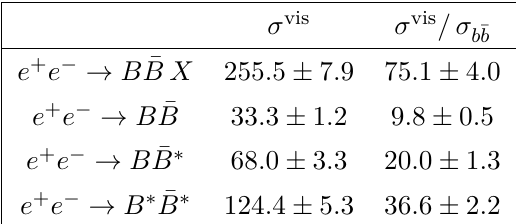
Table 8 . Visible cross sections σ vis (in pb) for various processes at Υ(5 S ) and corresponding σ vis / σ fractions (in %). The B ¯ B X final state includes B ( ∗ ) ¯ B ( ∗ ) and B ( ∗ ) ¯ B ( ∗ ) π ( π ) . The errors b ¯ b contain the statistical and systematic